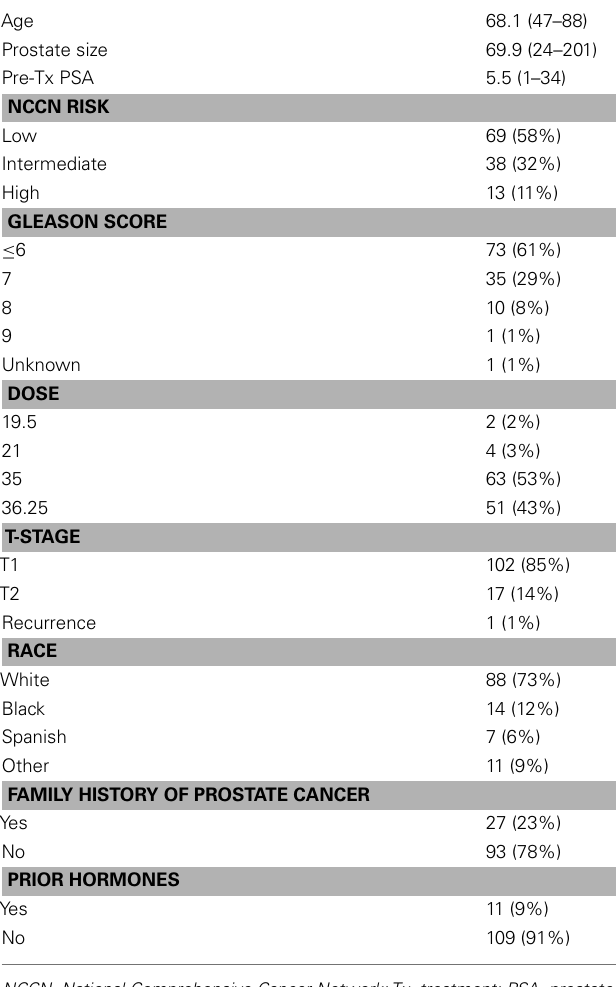
Table 1 | Patient and tumor characteristics .